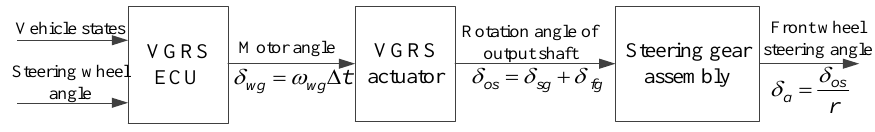
Figure 6. Three VGRS working modes [17].